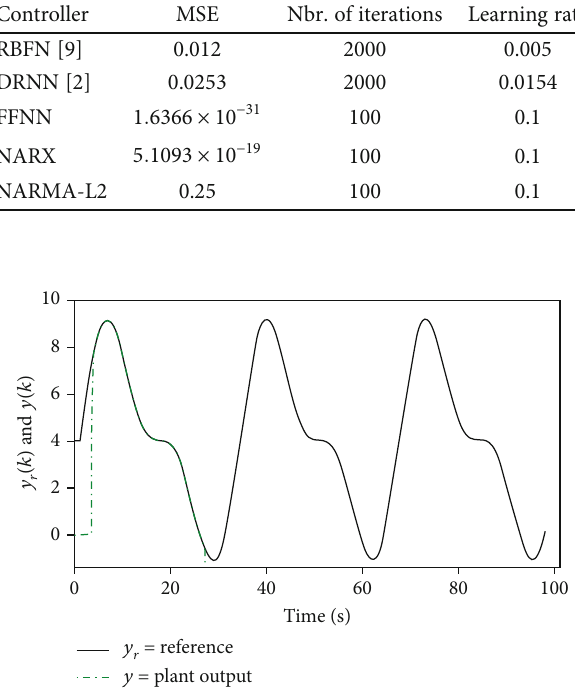
Figure 8: Plant output and reference model response for n = m = 1